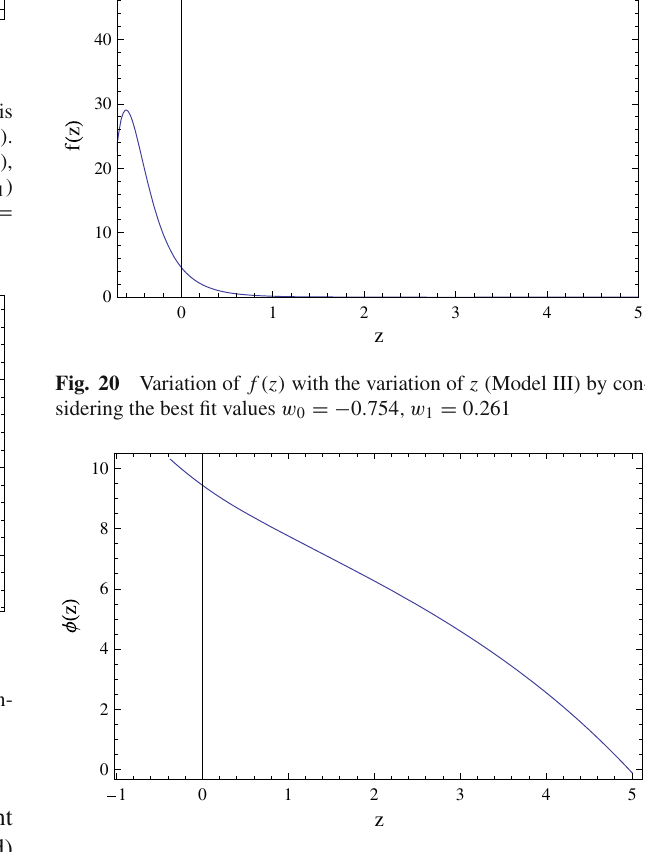
Fig. 21 Variation of φ( z ) with the variation of z (Model III) by con- sidering the best fit values w 0 = − 0 . 754 ,w 1 = 0 .